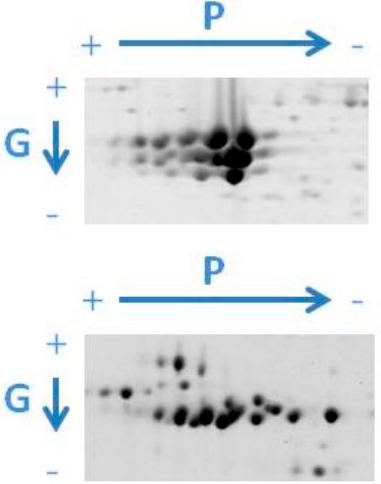
Figure 3. Gel images of differentially phosphorylated (P) and glycosylated (G) isoforms of phaseolin (above) and patatin (below) obtained by targeted 2 ‐ DE.